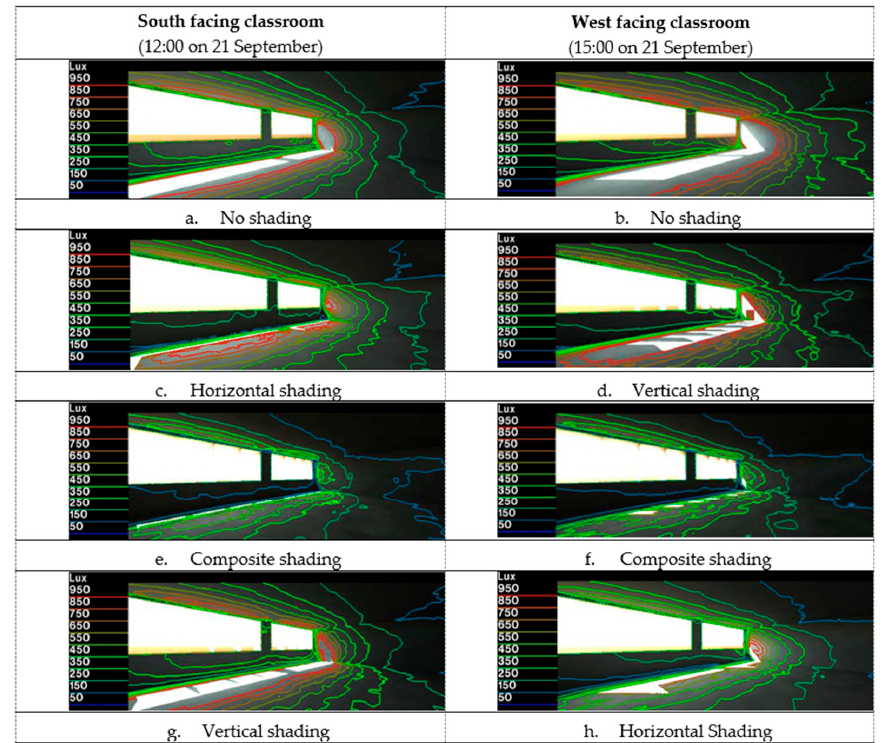
Figure 8. Internal illuminance is rendering with different shape of canopies with the intermediate sun in Seoul.